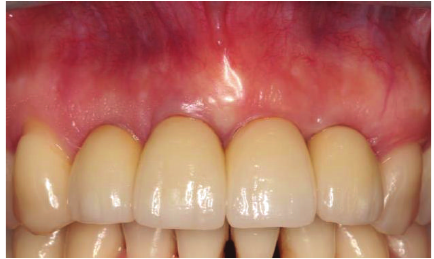
Figure 17: Soft tissue three months after tissue graft.